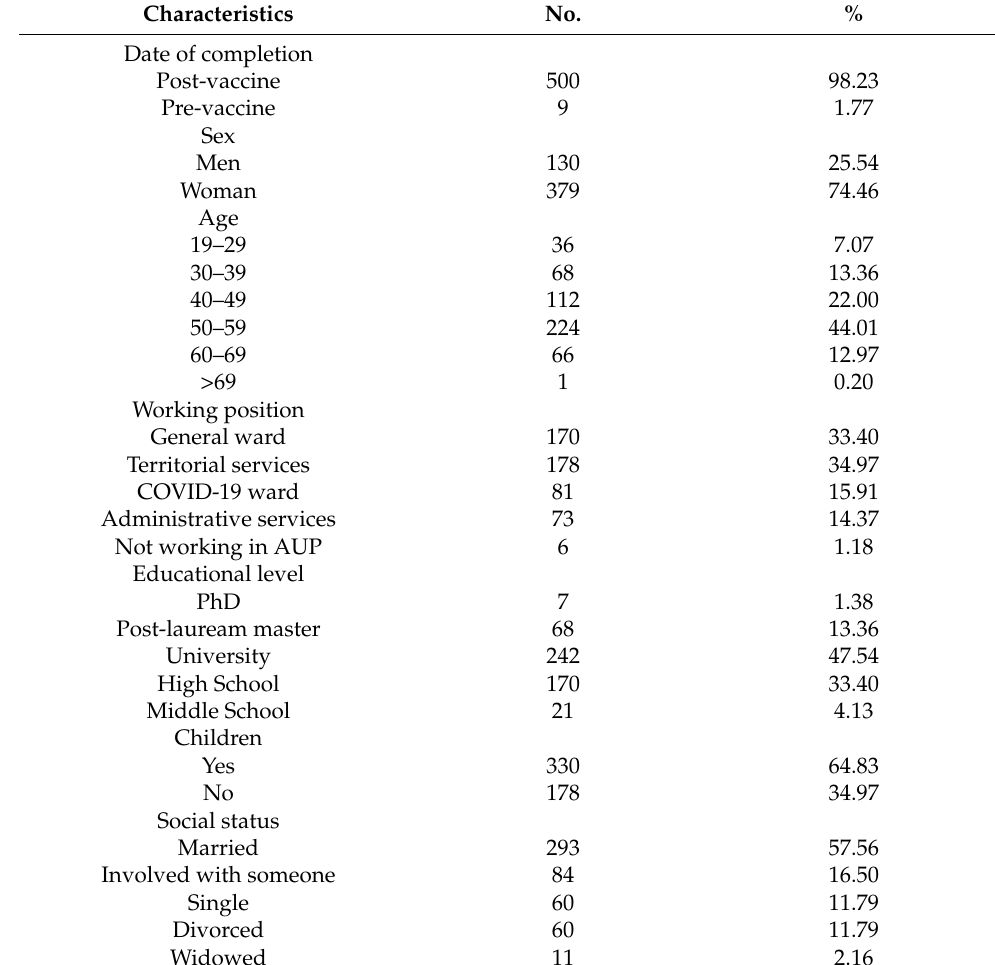
Table 1. Participant characteristics ( n =